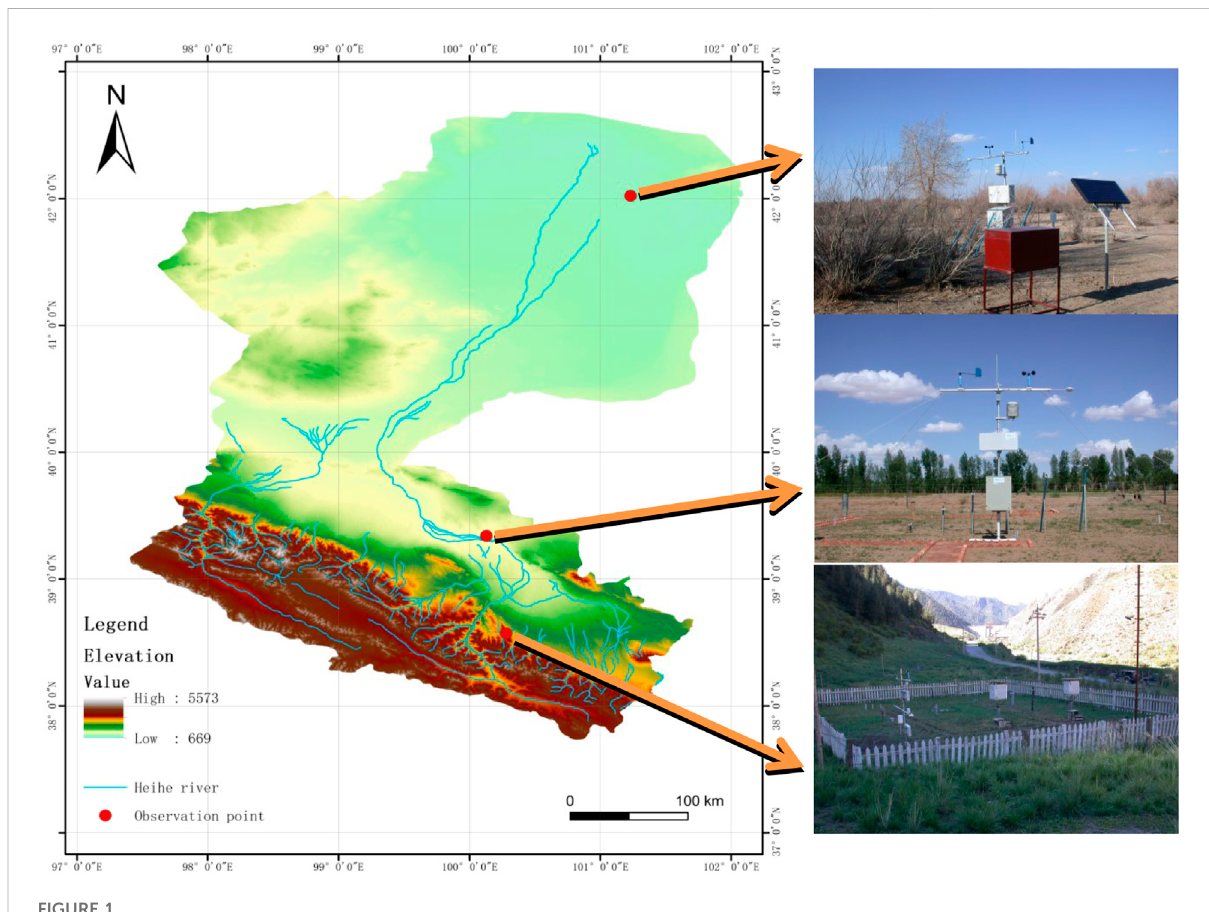
FIGURE 1 Distribution map of observation points in Heihe river